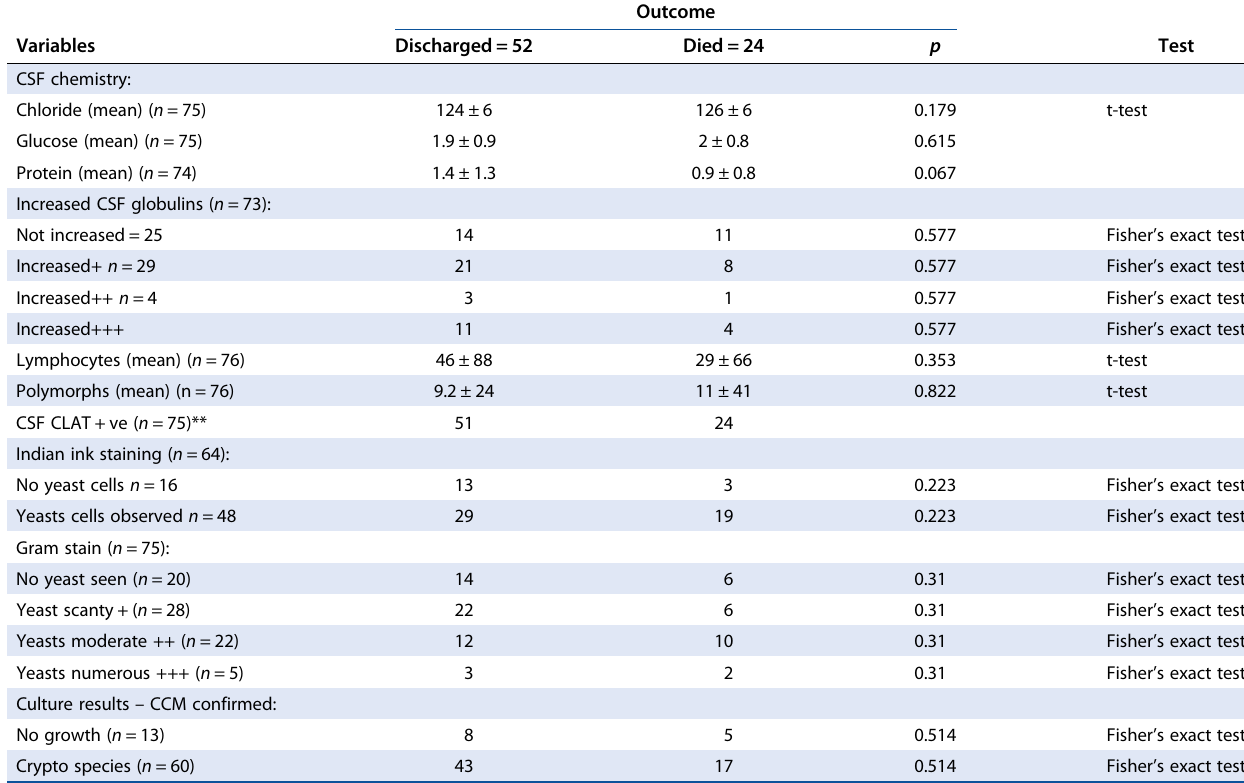
Table 2: CSF variables for patients admitted for CCM at PMMH 2015/2016